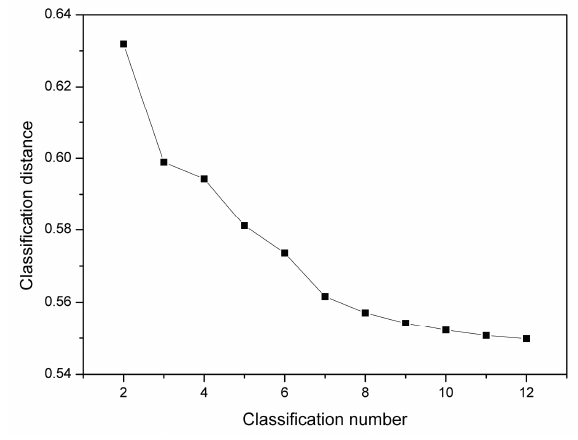
Figure 6. Relationship between the classification distance and the classification